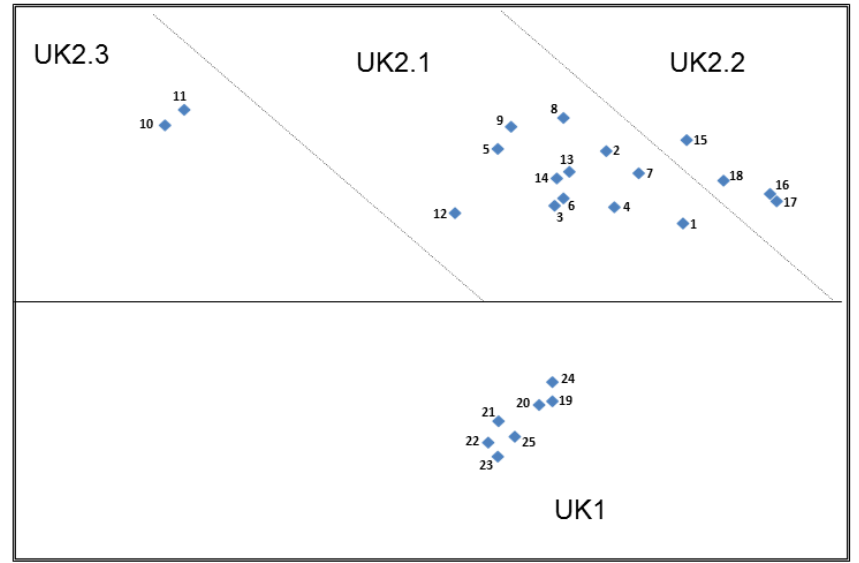
Figure 2. Multiple Scalogram Analysis (MSA) Top Plot—United Kingdom (UK). See Table 2 for the claims associated with the stimuli card